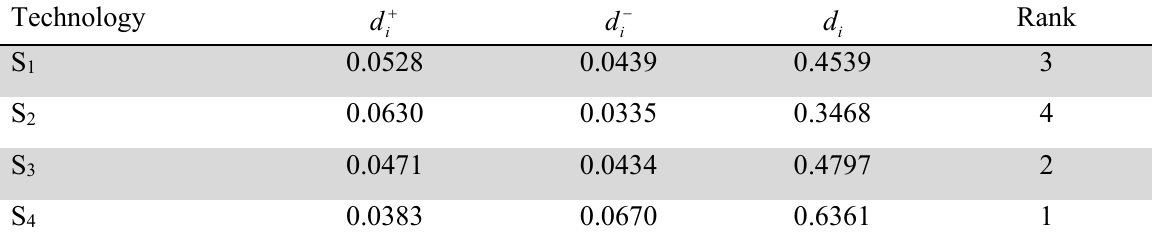
TOPSIS outputs for the EST